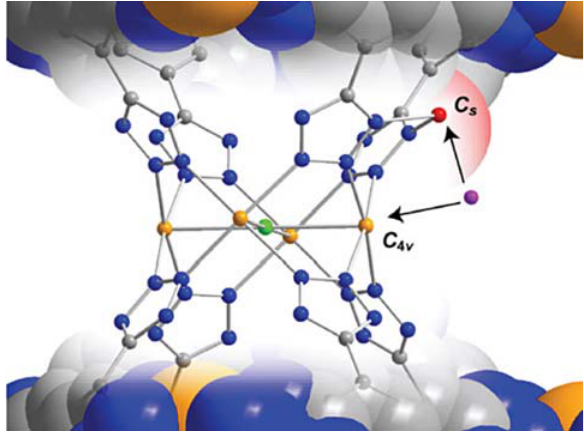
Figure 8. Exchangeable metal sites in M1M2BTT. Orange, red, green, blue, and gray spheres represent the C4v metal site, the par- tially occupied C s metal site, Cl, N, and C atoms respectively. The pink sphere represents the substituting cation. 136 Reprinted with permission. Copyright American Chemical